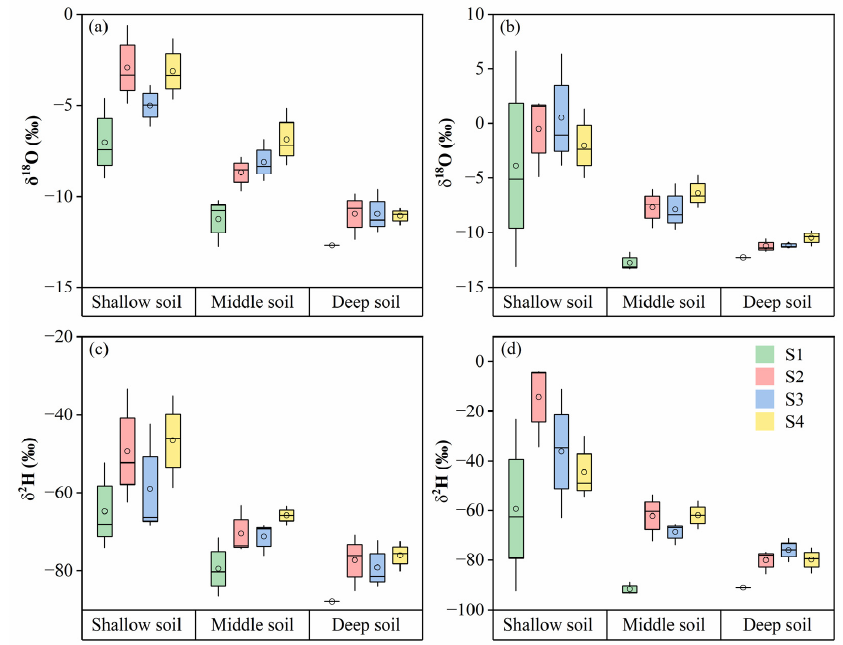
Figure 4. Distribution characteristics of the δ 18 O and δ 2 H values in soil water during June 2022 ( a , c ) and July 2022 ( b , d ).